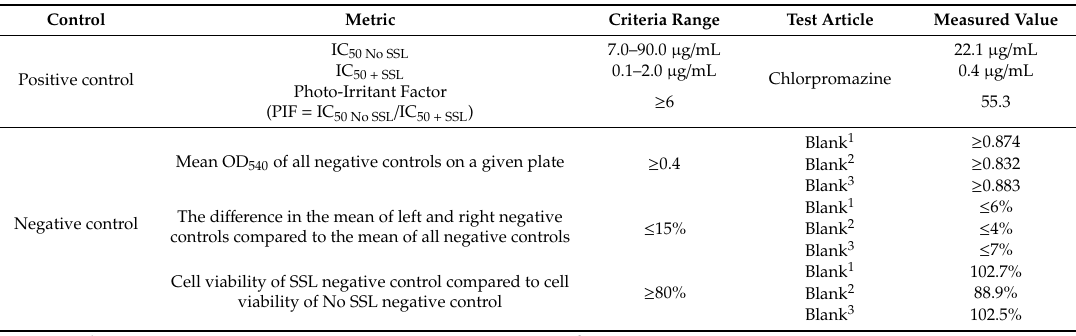
Table 2. Positive and negative control acceptance criteria and results per OECD 432